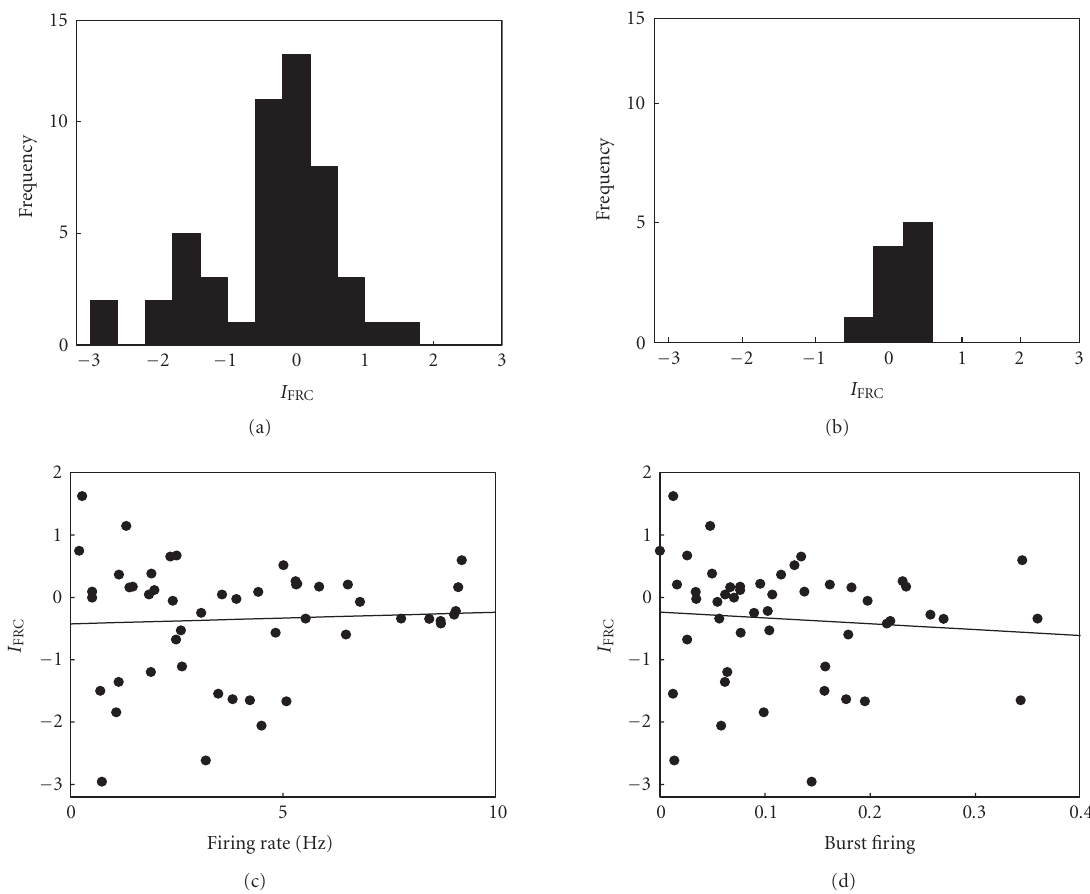
Figure 4: MA e ff ects in awake animals. (a)-(b) I FRC frequency histograms following MA or vehicle administration. (c)-(d) Relationships between the index of firing rate change and physiological indices. None were significant. The format is as in Figure 3.